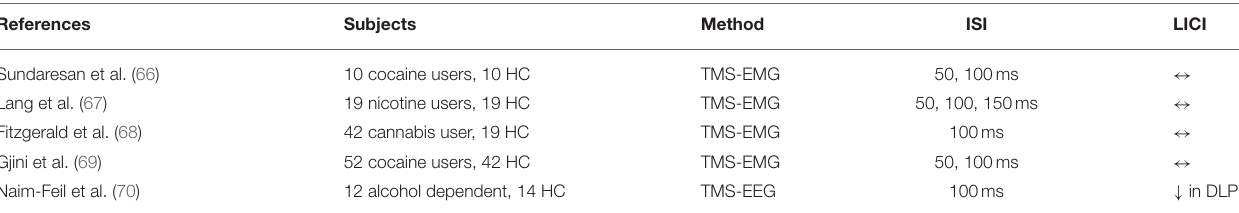
TABLE 6 | LICI in patients with substance